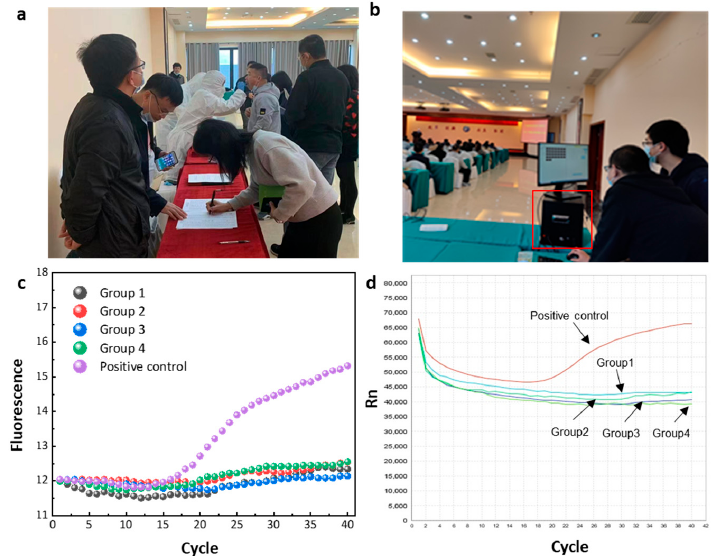
Figure 6. ( a ) Sampling from the conference site: upper respiratory tract nasopharyngeal swabs were used as nucleic acid detection samples. ( b ) Using the HDLRT-qPCR system (the part circled by the red frame) instrument for detection and analysis on-site. ( c ) On-site nucleic acid test results of the HDLRT-qPCR system. ( d ) Amplification curve obtained by using the ABI-STEPONE fluorescence quantitative PCR instrument for amplification detection of nucleic acid samples collected from the same batch in the laboratory. Experiments show that the amplification curve obtained by on-site sampling and analysis of the HDLRT-qPCR system is basically consistent with the curve obtained by the amplification analysis using the commercial instrument ABI-STEPONE system in the laboratory. This proves that the HDLRT-qPCR system can successfully perform field